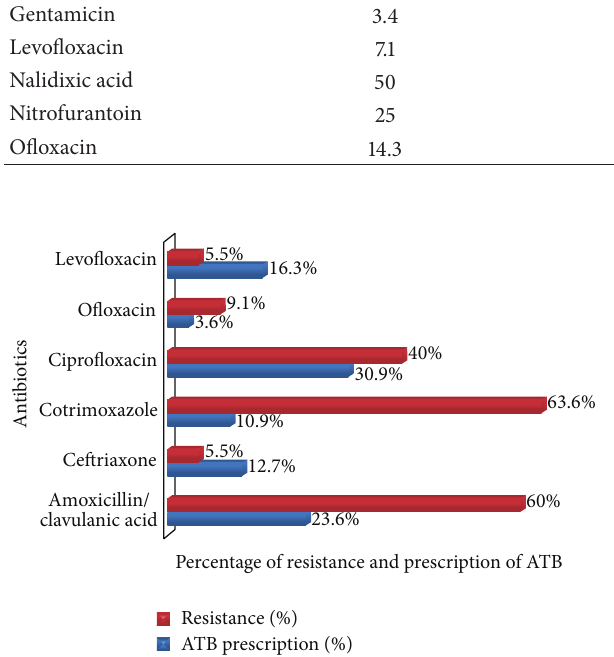
Figure 3: Prevalence of resistance (%) to empirical antibiotics pre-